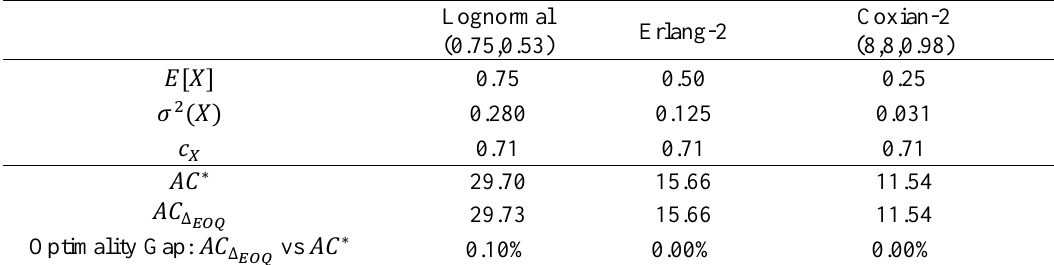
Table 4. The impact of processing time distributions with different 𝐸[𝑋] and 𝜎 2 (𝑋) but same 𝑐 𝑋